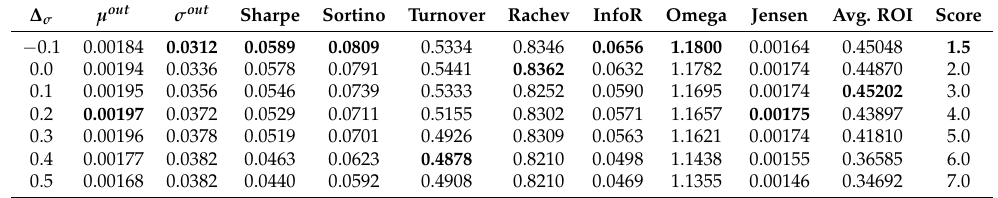
Table 4. ES50: out-of-sample performance results for the KP R strategy by varying ∆ σ (with ∆ γ =